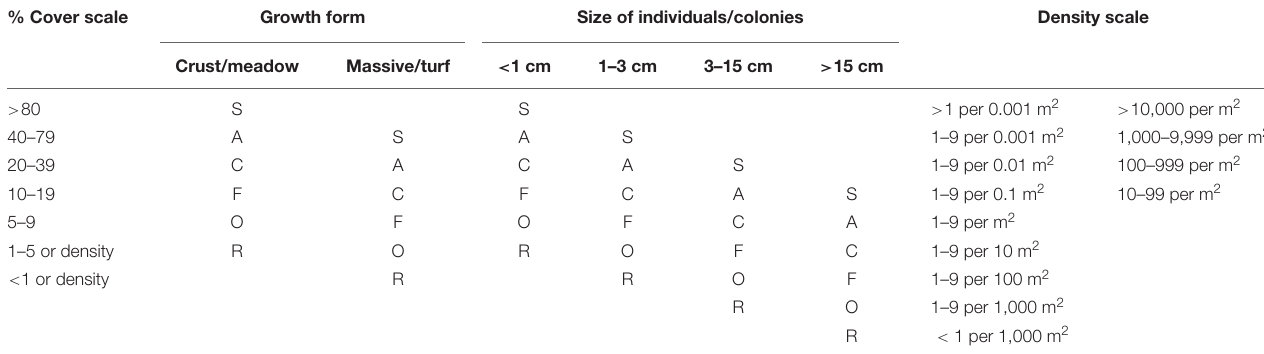
TABLE 1 | The SACFOR abundance measure and how it is applied to different morphotypes and size classes. From Hiscock (1996). % Cover